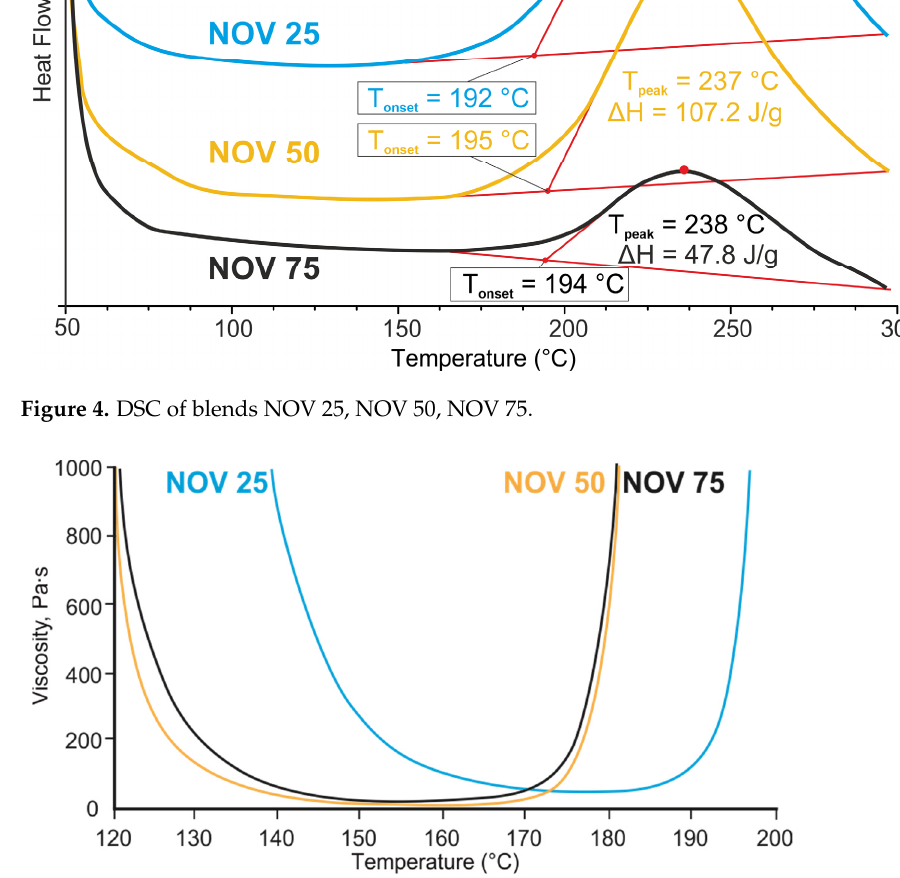
Figure 4. DSC of blends NOV 25, NOV 50, NOV 75.